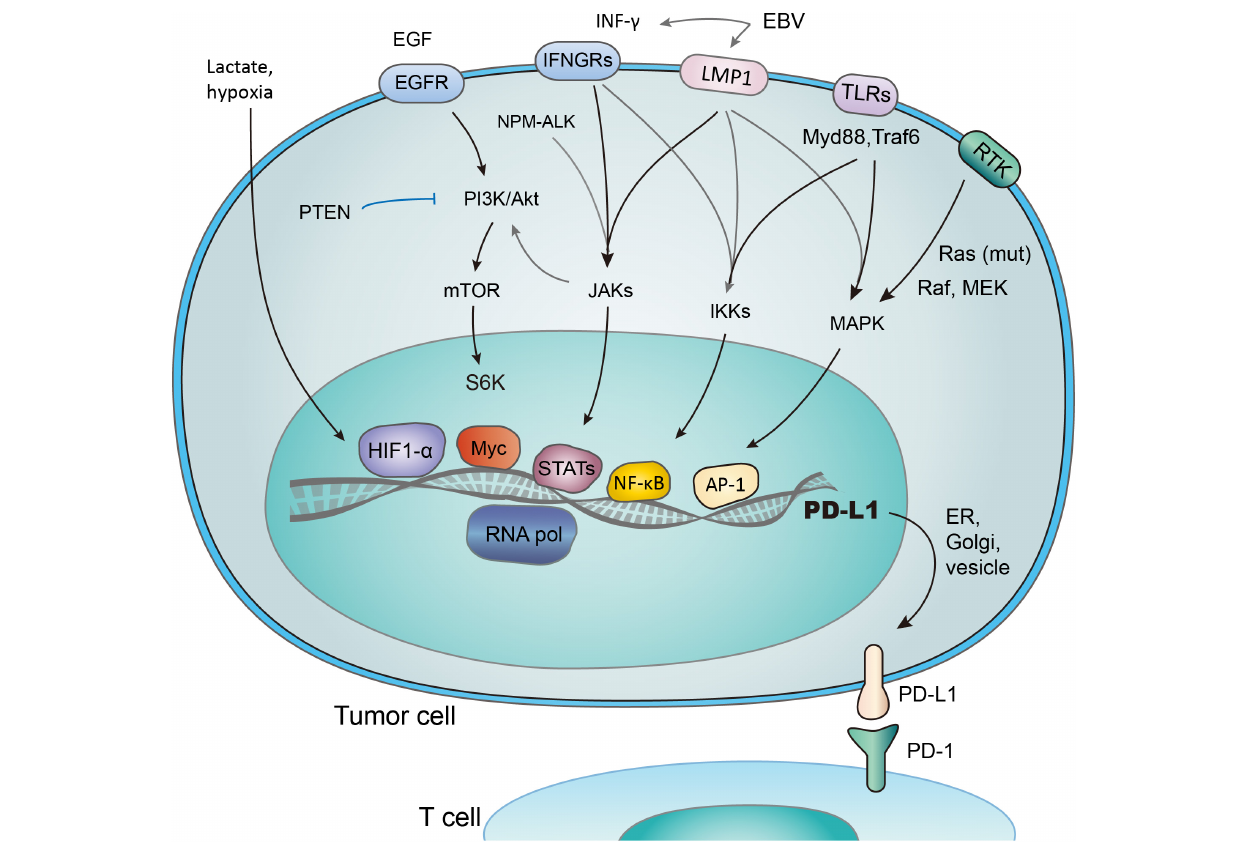
FIGURE 2 | Transcriptional activation of PD-L1 in response to different signaling pathways. PD-L1 is transcribed in response to the activation of multiple signaling pathways, and transcription factors (TFs) such as HIF1- α , Myc, Stats, NF- κ B, and AP-1 have been reported to bind and transactivate PD-L1. These TFs are controlled by the interconnected pathways involving EGF/PI3K/AKT/MTOR (suppressed by PTEN), RTK/Ras/Raf/MEK/ERK, IFN- γ /JAKs (also induced by mutant NPM-ALK gene and EBV-activated LMP1), TLRs/Myd88/Traf6/IKKs, and lactate-enriched